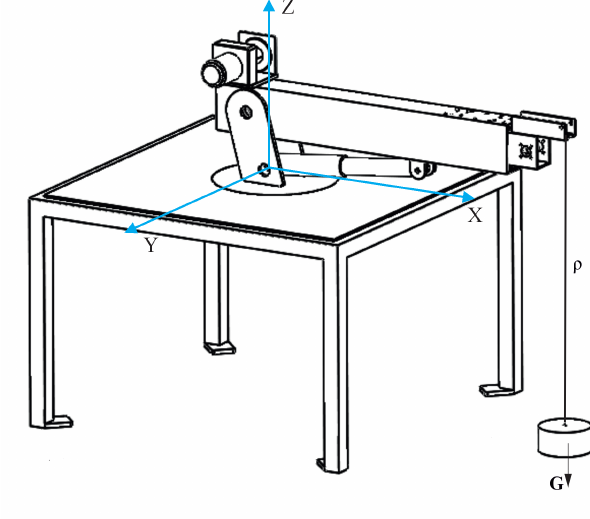
Figure 4. Numerical